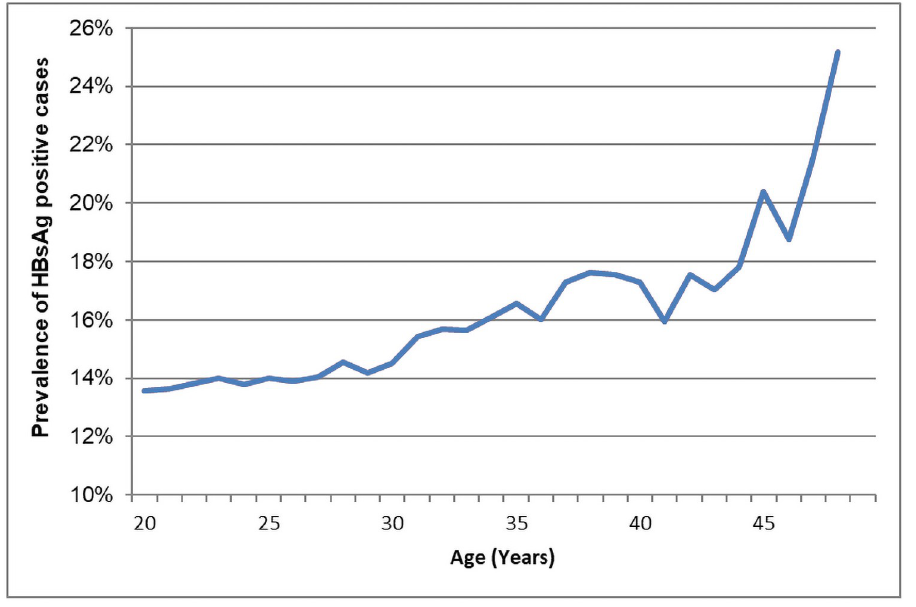
Fig 1. HBsAg prevalence in couples by age.